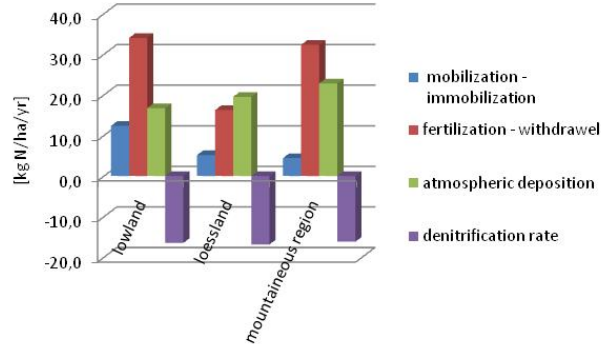
Fig. 7. Driving forces of N-leaching rate and its divisions from the rooted soil zone on arable land in